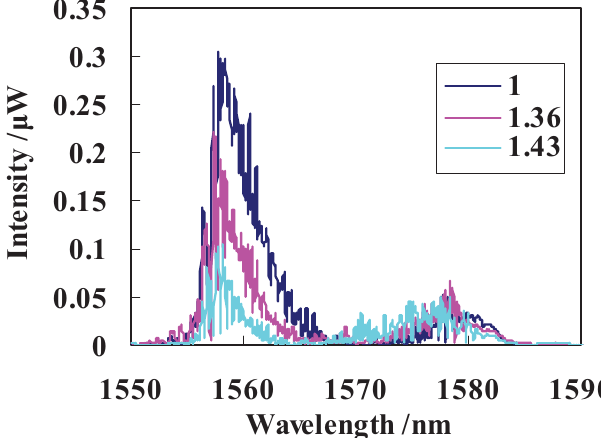
Figure 4. Reflected spectrum changes of hybrid LPG/CFBG at different